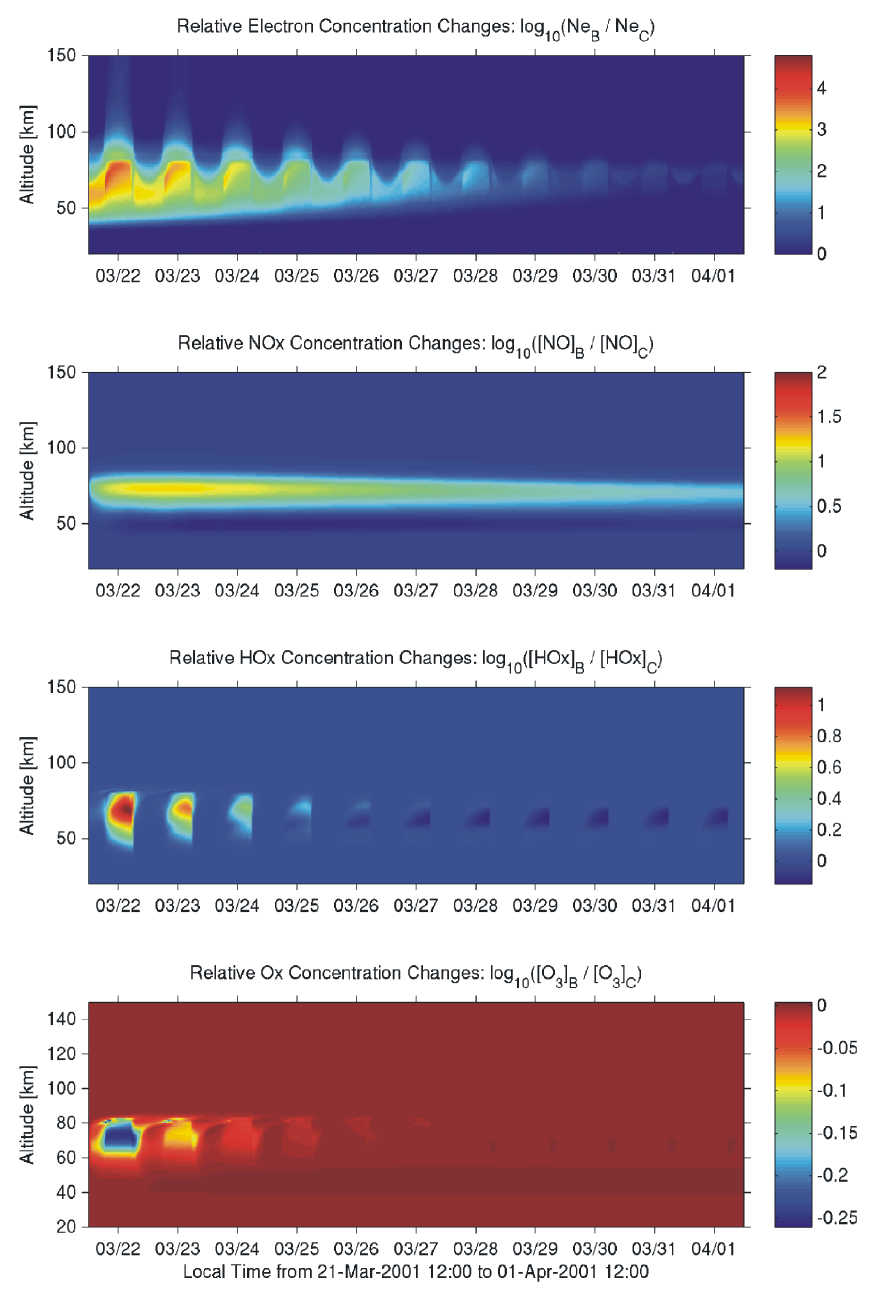
Fig. 8. The effect of the RBR-forced precipitation starting at 12 LT, in the same format as Fig. 7. In this case the RBR-system is assumed to flush the HANE-injected electrons into the upper atmosphere over 10